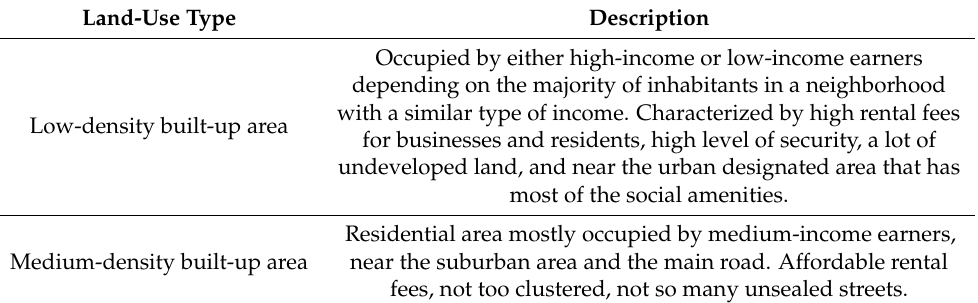
Table 2. Land use classification